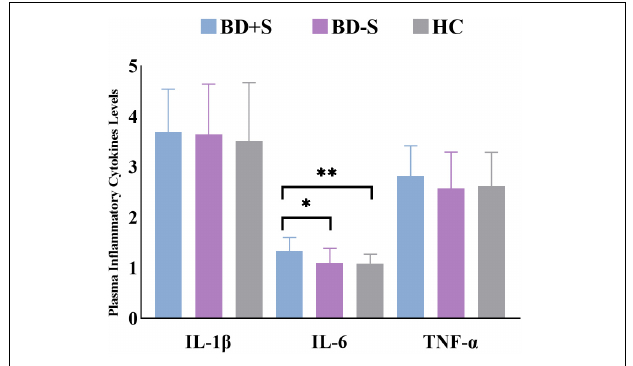
FIGURE 1 | Levels of IL-1 β , IL-6, and TNF- α in the BD + S, BD-S, and HC groups. ∗∗ p < 0.01; ∗ p < 0.05.